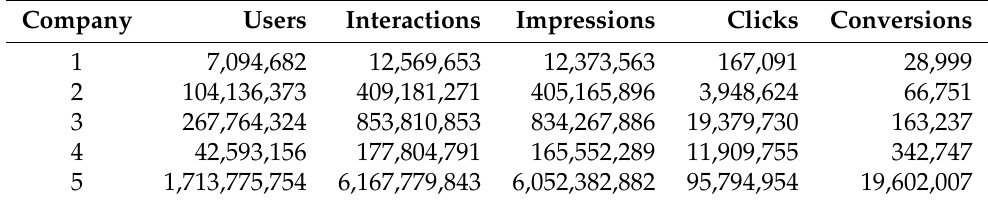
Table 1. Each of the rows represent a different dataset from a different client. Each of the cells has the amount of events that we have for each of the different interactions. Company Users Interactions Impressions Clicks